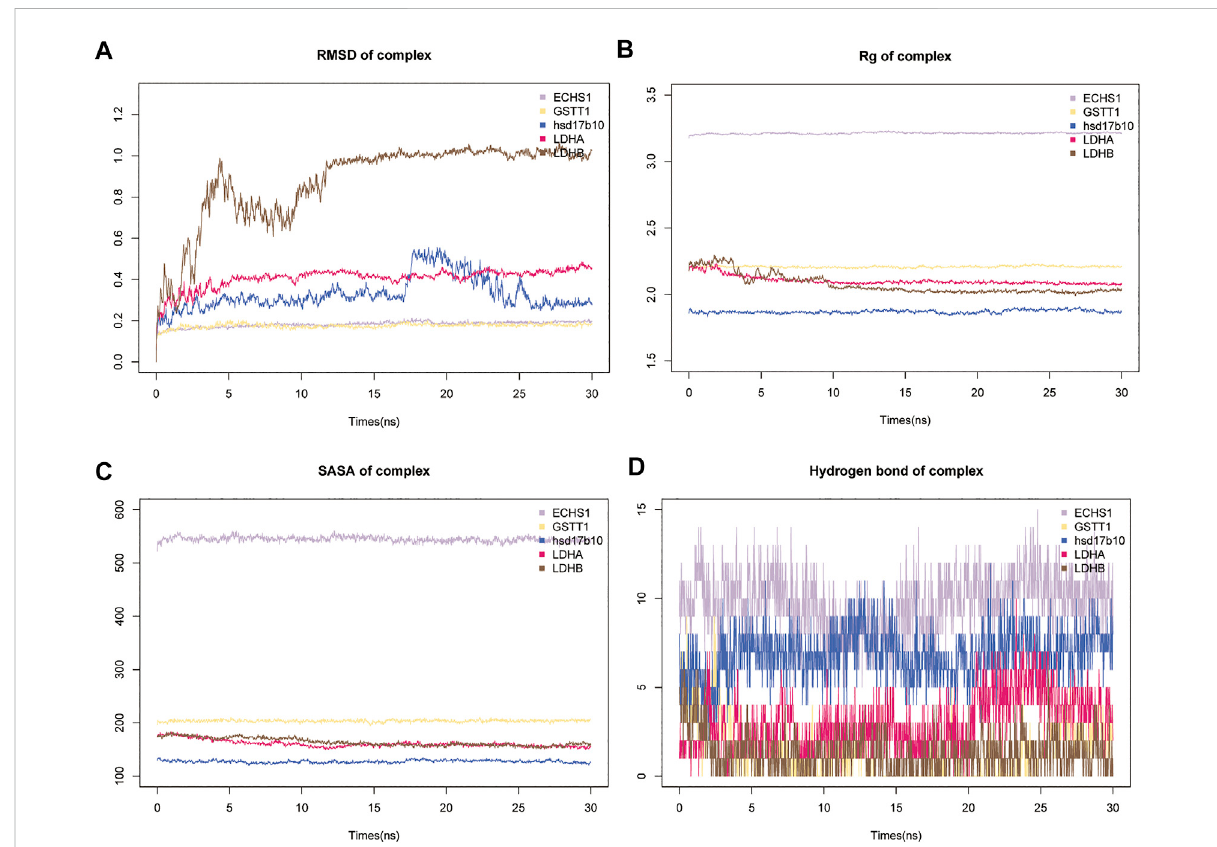
FIGURE 6 Results of molecular dynamics simulations (MDS) of fi ve key metabolic enzymes. (A) The atomic root mean square deviation (RMSD) of the protein-metabolite complex MDS. (B) Rg variation of protein-metabolite complex MDS. (C) Solvent accessible surface area (SASA) variation of proteins in 0 – 3 ns of protein-metabolite complex MDS. (D) Changes in hydrogen bonding in the steady state of protein-metabolite